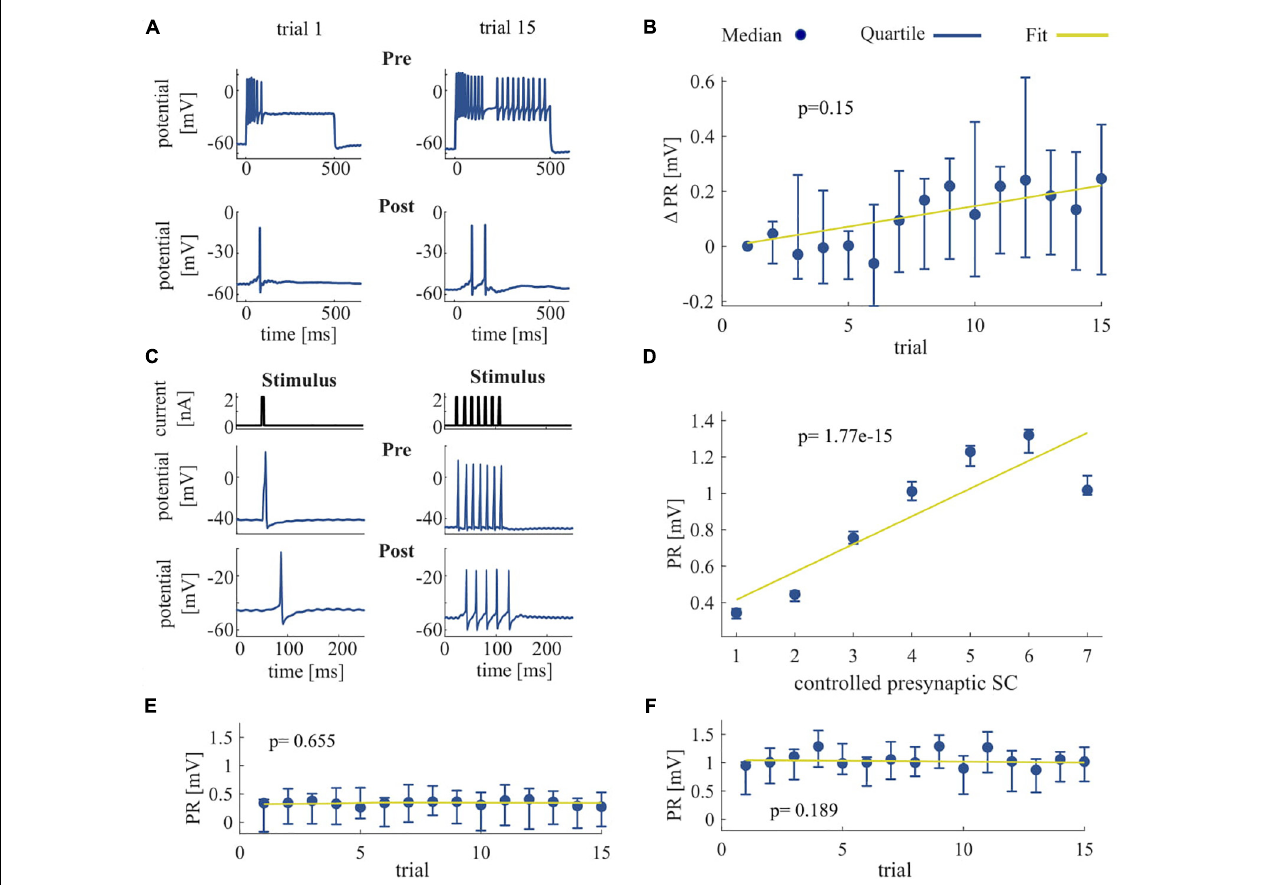
FIGURE 4 | Effect of repeated somatic current stimulation on the communication between two ipsilateral T cells. (A) Representative responses of an intracellularly recorded T cell pair to a 500 ms long somatic current injection of 1 nA in two different trial repetitions. (B) PR difference from first trial [mV] as median and quartiles of all T cells ( N = 11) vs. trials. (C) Representative responses of an intracellularly recorded T cell pair to one and seven short current pulses. (D) Dependency of PR as median and quartiles of all T cells ( N = 14) on controlled presynaptic SC. (E,F) Dependency of PR as median and quartiles of all T cells ( N = 14) for one (E) and for seven (F) presynaptic spikes vs. trials. The slope of the PR vs. trial was not significant for six out of seven conditions (1 pulse, p = 0.655; 2 pulses, p = 0.032; 3 pulses, p = 0.092; 4 pulses, p = 0.051; 5 pulses, p = 0.772; 6 pulses, p = 0.512; 7 pulses, p = 0.190). Linear fits were calculated for each cell individually and the obtained slopes were tested to differ significantly from 0 ( t -test, α = 0.05). Yellow line indicates the average of the fits for all cells.